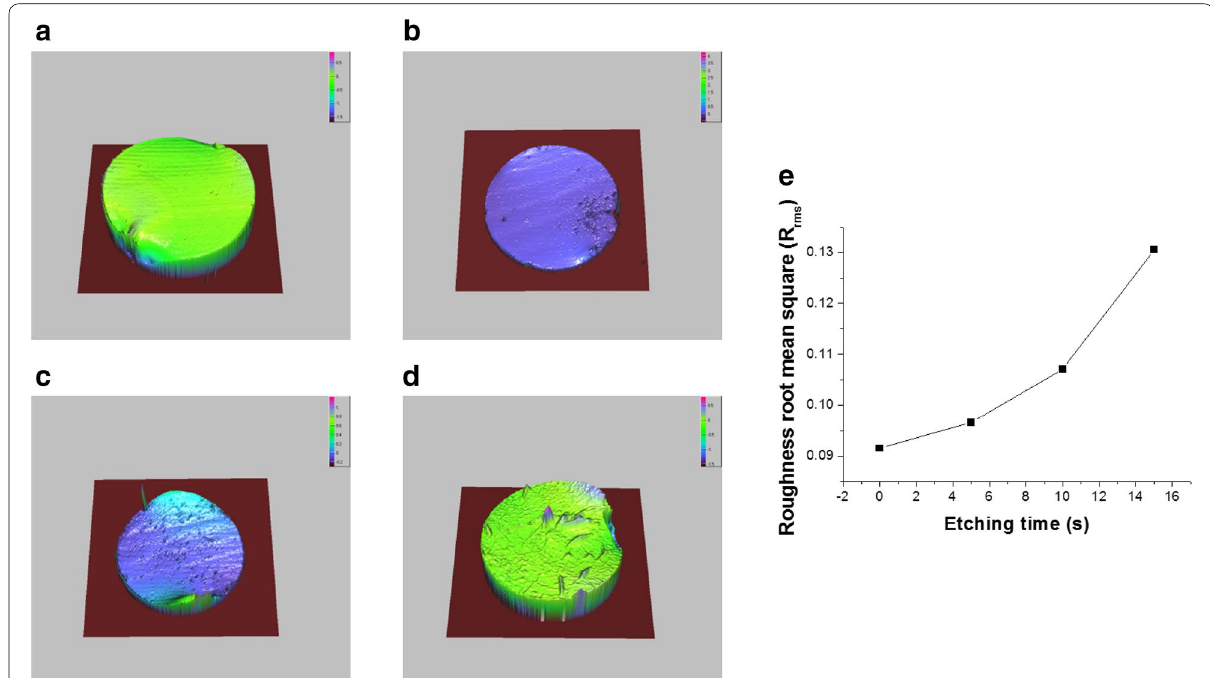
Fig. 5 Optical fiber surface image measured with 3D surface profiler a 0 s etching, b 5 s etching, c 10 s etching, d 15 s etching, respectively, and e roughness root mean square of the surface of optical fiber with etching time